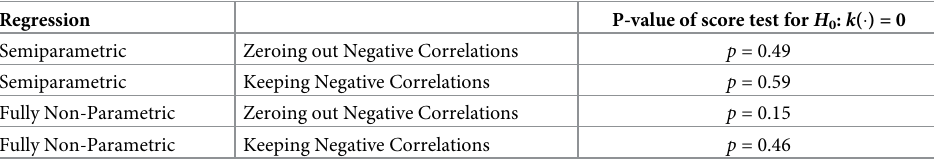
Table 3. Analysis of COBRE dataset—Paranoid schizophrenia cases